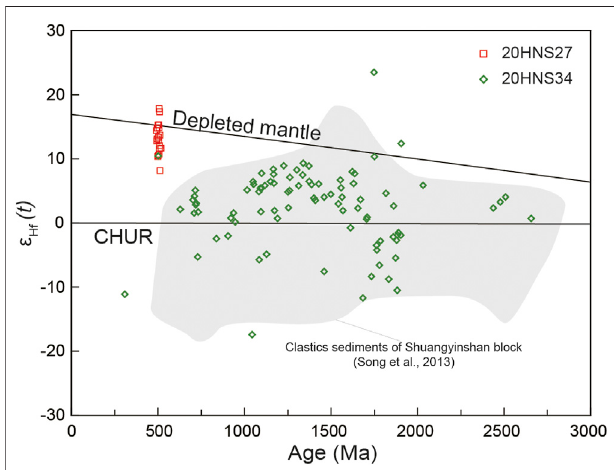
FIGURE 7 | ε Hf (t) vs. age diagram for the Huaniushan complex in the Beishan orogen. The Hf isotope data of the sediments from the Heiyingshan block are after (Song et al., 2013).